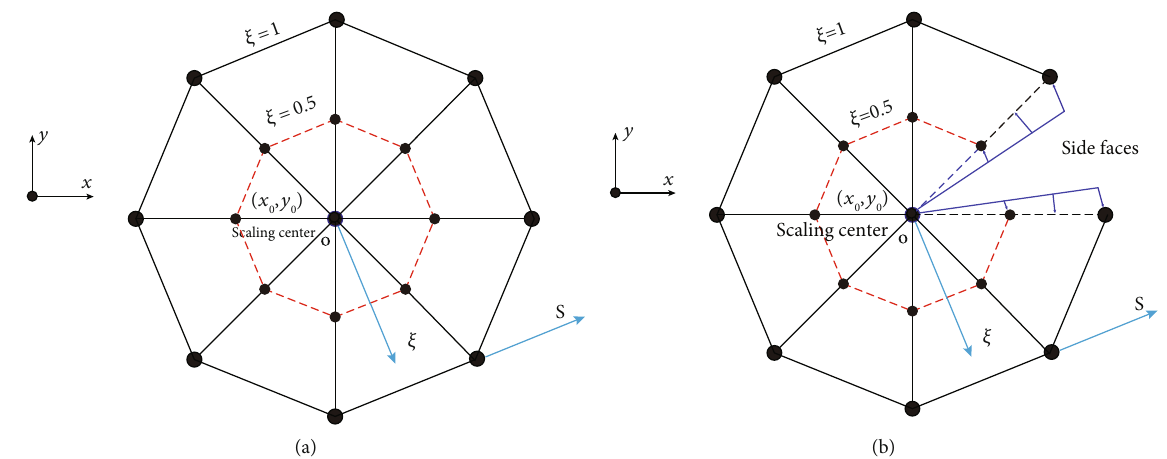
Figure 1: Polygon representation of SBFEM: (a) polygon S -domain; (b) polygon S -domain with